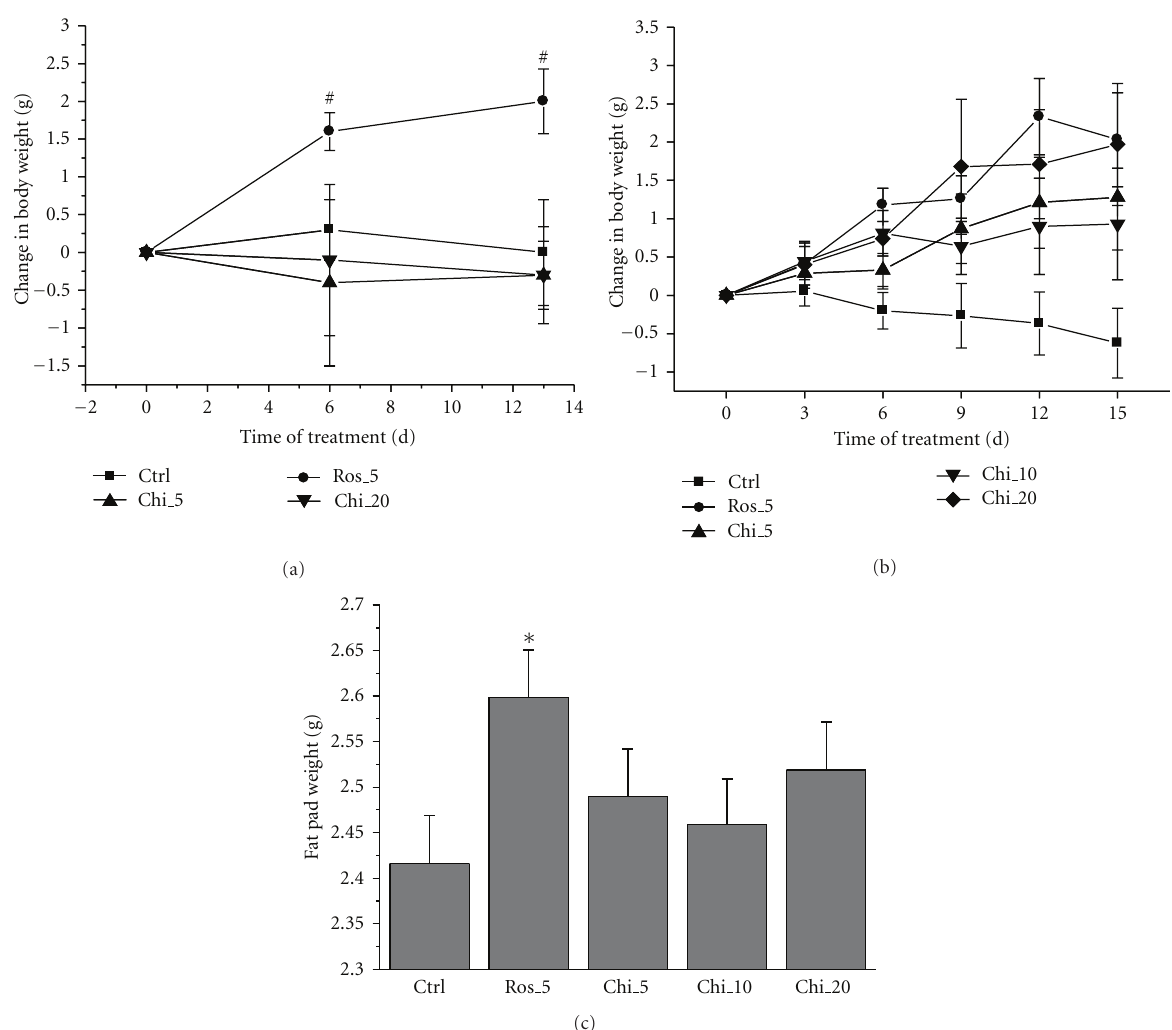
Figure 4: Influence in body and abdominal fat pad weights of chiglitazar. (a) Male KKAy mice were orally administered daily with vehicle (Ctrl), rosiglitazone (Ros) of 5mgkg − 1 , or chiglitazar (Chi) of 5 and 20 mgkg − 1 for 12 days, and changes in body weight were evaluated at the indicated days. (b) and (c) Male db/db mice were orally administered daily with vehicle (Ctrl), rosiglitazone (Ros) of 5 mgkg − 1 , or chiglitazar (Chi) of 5, 10, and 20 mgkg − 1 for 14 days. Changes in body weight were evaluated at the indicated days (b), and the fat pads were weighed from the scarified animals at day 15 (c). # P < 0 . 05 compared with day 0, and ∗ P < 0 . 05 compared with Ctrl. n = 8 per group for KKAy, and n = 10 per group for db/db . Data are expressed as mean ±